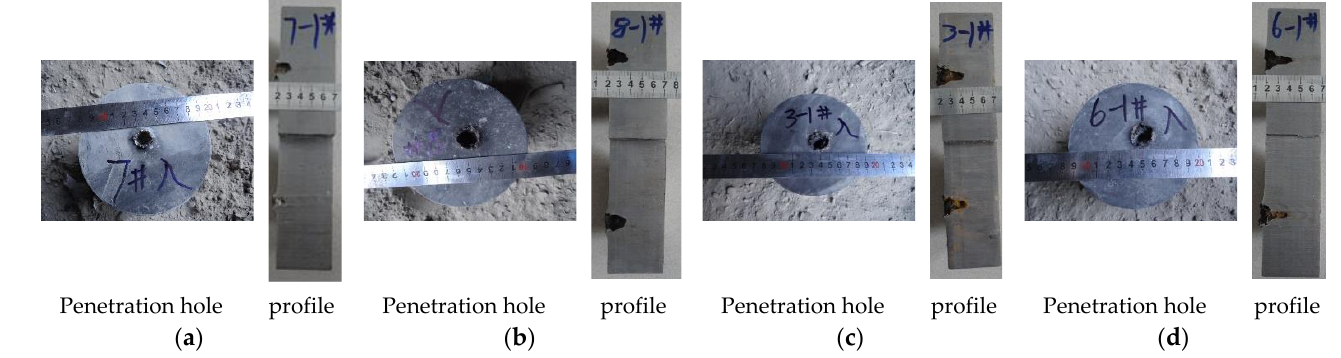
Figure 15. Results of target penetration by expansive jet from warheads of different materials: ( a ) PTFE; ( b ) PTFE/Cu-1; ( c ) PTFE/Cu-2; ( d ) PTFE/Cu-3. (The accuracy of the scale is 0.5 mm).